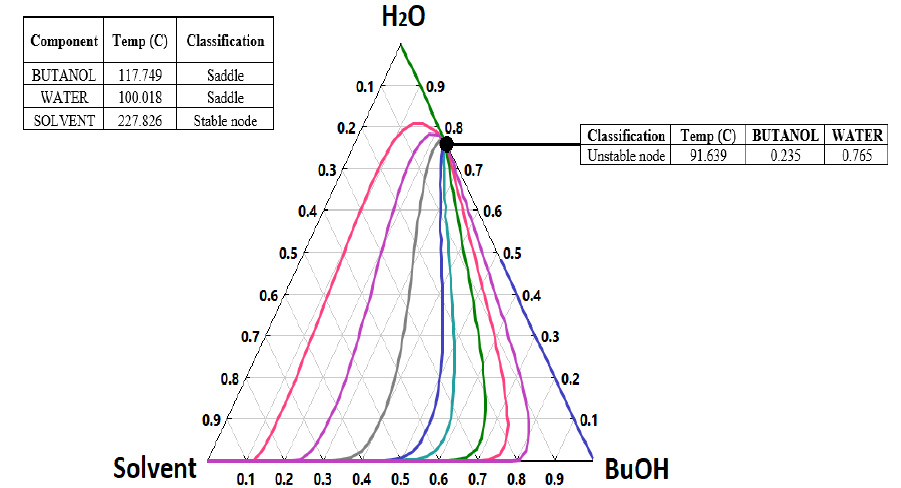
Figure 2. Residue curves map of the water- n -butanol-1,4-butanediol mixture at a pressure of 101.3 kPa.